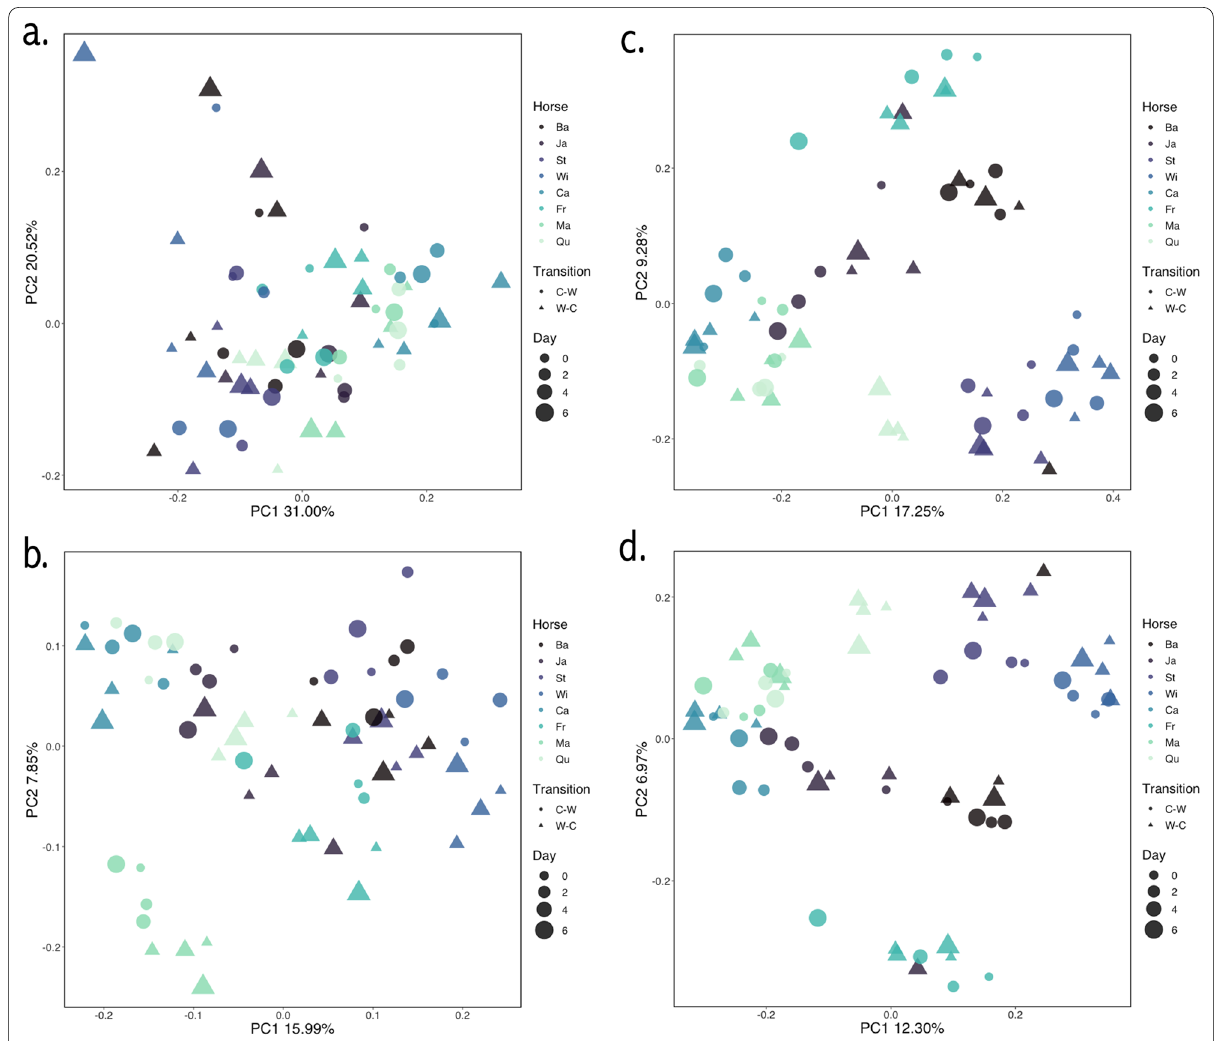
Fig. 2 Fecal microbiota β‑diversity following transitions between cool‑season and warm‑season grass. Metrics including a Weighted UniFrac, b Unweighted UniFrac, c Bray Curtis Dissimilarity, and d Jaccard Index were analyzed for transitions from cool‑season to warm‑season grass (C–W) and warm‑season to cool‑season grass (W–C) in both the bermudagrass integrated rotational grazing system (BRS) and the crabgrass integrated system (CRS). Individual horses are designated with two‑letter abbreviations and arranged such that horses on the darker end of the color spectrum grazed in BRS (n 4) and horses on the lighter end of the color spectrum grazed in CRS (n = (v.2020.8) found that the influence of individual horse was the most influential factor shaping β‑diversity across all metrics (R 2